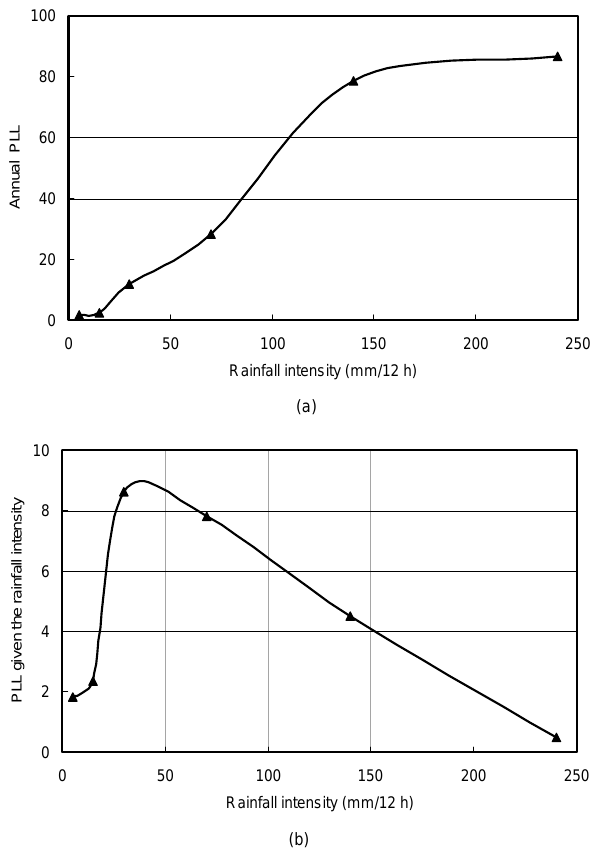
Fig. 14. Relationship between 12-hour rainfall and PLL between K1 and K18 ( a : Annual PLL; b : PLL given the rainfall intensity).